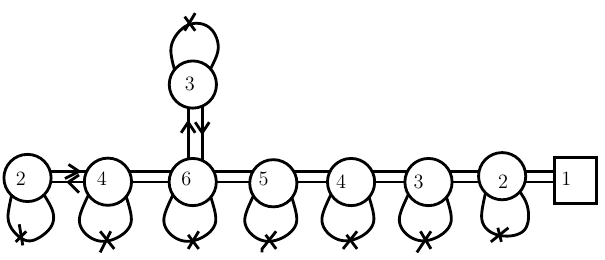
Figure 39 . The a(cid:14)ne quiver diagram corresponding to compacti(cid:12)cation on torus of E 8 minimal conformal matter with (cid:13)ux 1 = 30 for the U(1) corresponding to central node of one of the two E 8